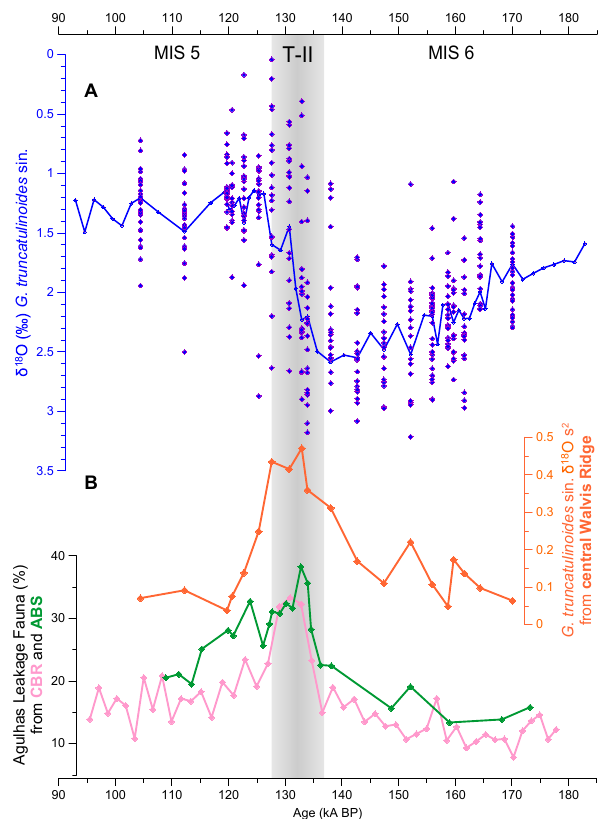
Fig. 2. (A) : δ 18 O of G. truncatulinoides sin. individuals (blue dia- monds) and bulk analysis (blue line, Scussolini and Peeters, 2013). (B) : corrected sample δ 18 O variance (orange, see Methods); estima- tion of AL from the Cape Basin record (CBR, Peeters et al., 2004) (pink), and from the Agulhas Bank Splice (ABS, Martínez-Méndez et al., 2010)